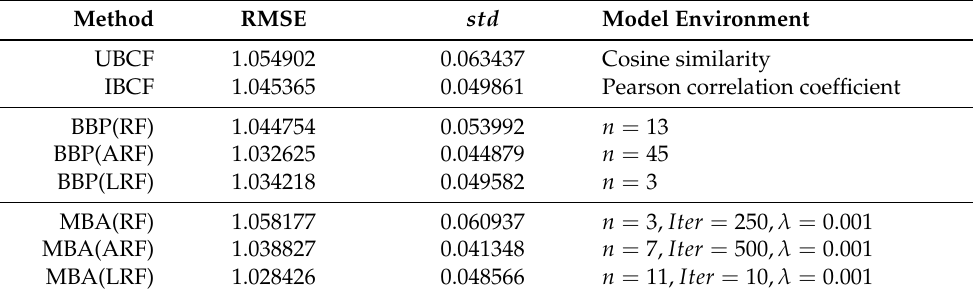
Table 3. Root mean square error (RMSE) comparison of the methods used in the experiment. RMSE results of five-fold cross-validation of every method can be viewed in more detail in Table A1 of Appendix A.